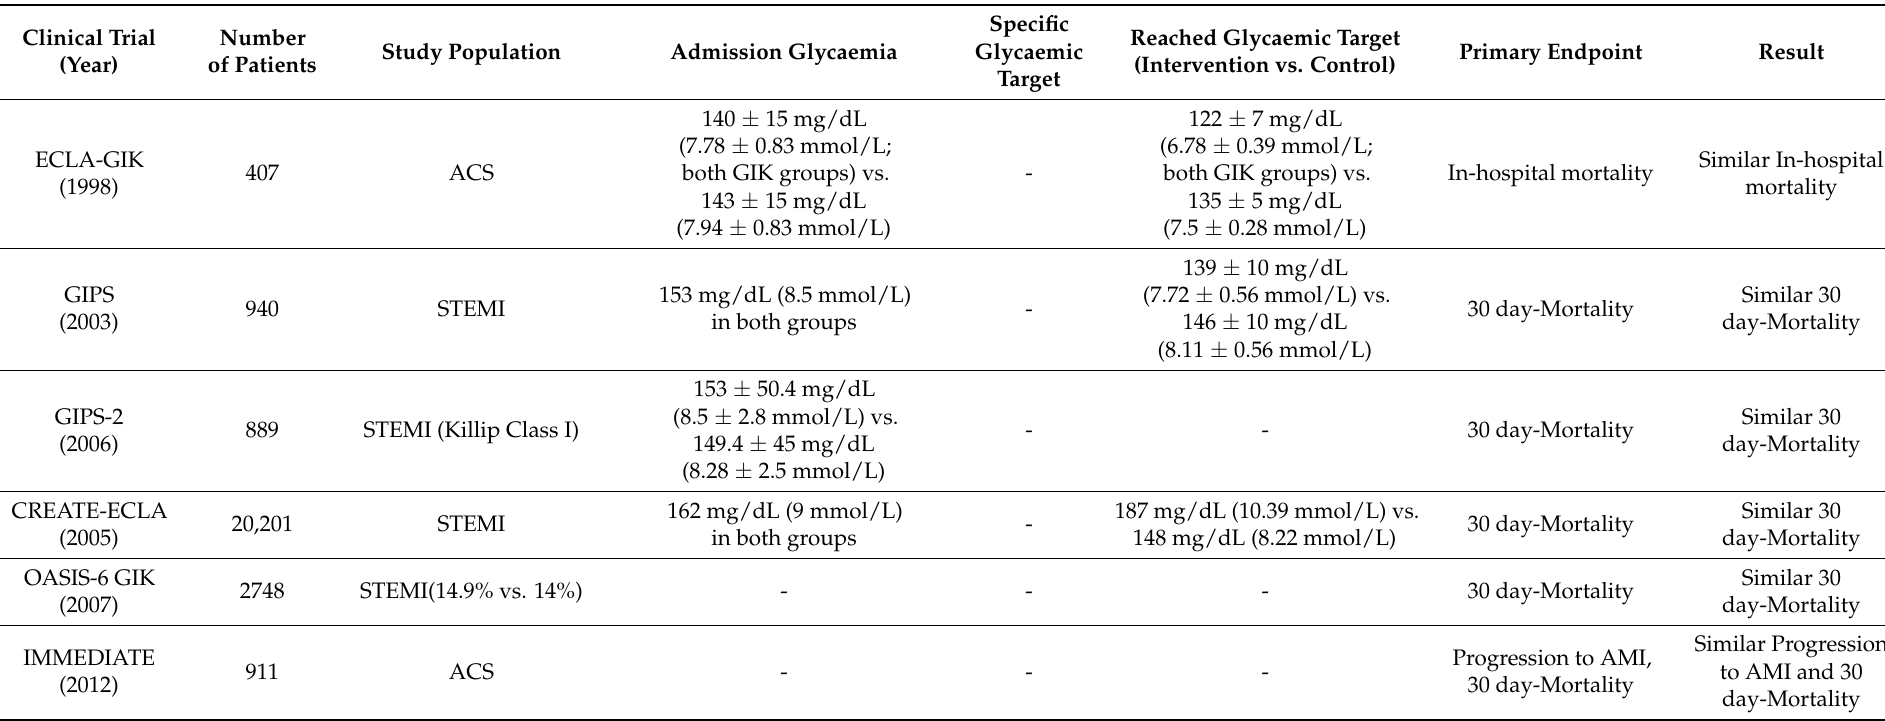
Table 2. Synopsis of randomized clinical studies designed to compare the effect of glucose-insulin-potassium (GIK) versus standard therapy, independently on achievement of a specific glycaemic target, in populations comprising a large percentage of non-diabetic patients with acute hyperglycaemia at admission for acute coronary syndrome